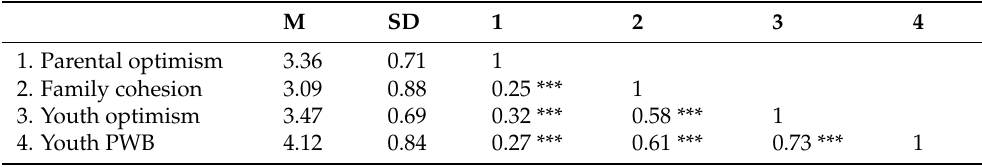
Table 1. Descriptive analysis and correlations of main variables (N = 332).